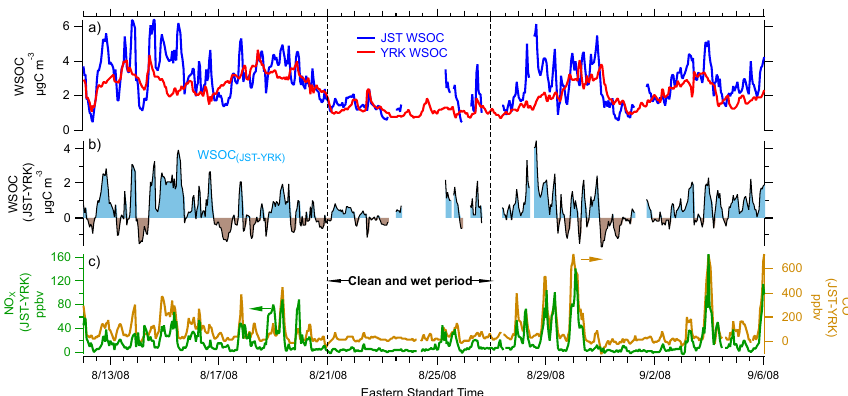
Fig. 8. Time series of WSOC and other parameters measured at Jefferson St. (JST) and Yorkville (YRK) from 12 August 2008 to 6 September 2008 during the AMIGAS field campaign: (a) absolute WSOC concentrations at the two sites; (b) WSOC difference ( 1 WSOC) between the two sites (i.e. WSOC JST minus WSOC YRK ) ; (c) CO and NO x difference between the two sites (i.e. CO JST minus CO YRK , NO x JST minus NO x YRK )